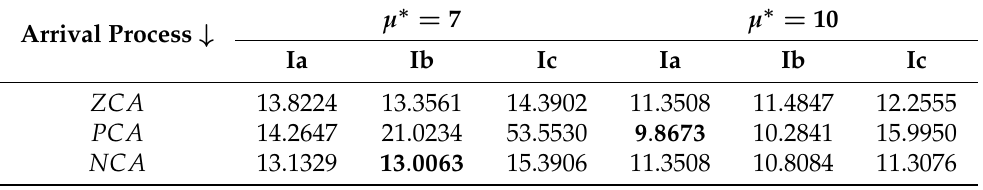
Table 15. Cost per unit time in Scenario